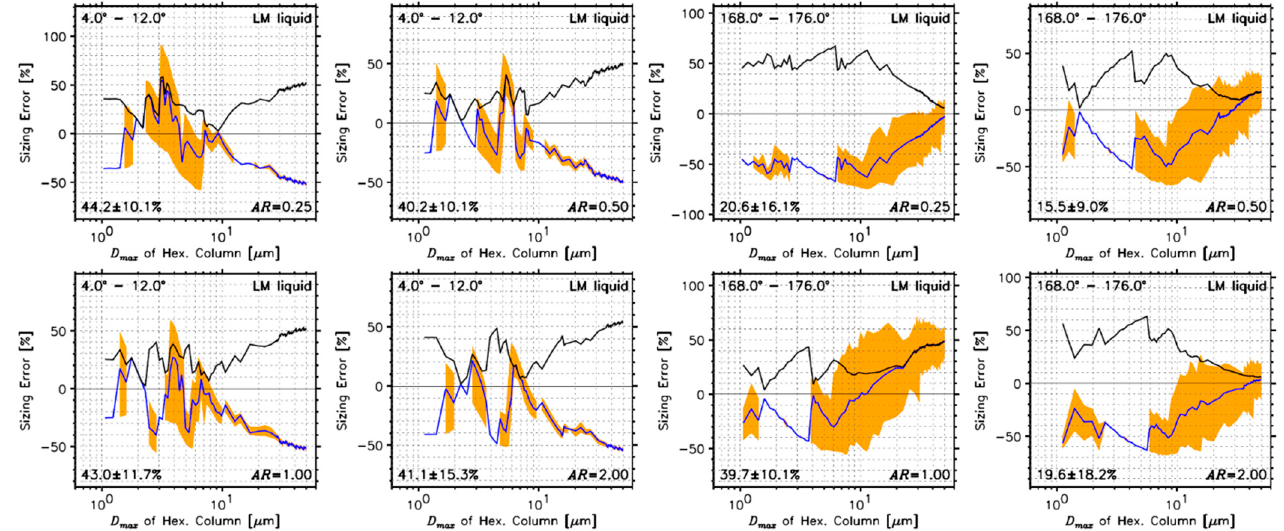
Figure 8. Determined sizing errors of hexagonal ice crystals in forward (4°–12°, left two columns ) and backward (168°–176°, right two columns ) directions. The sizing errors are calculated using an exact comparison between the measured D max of hexagonal ice crystals and those calculated by a Lorenz–Mie code assuming spherical liquid cloud droplets (LM liquid). Each panel represents a different aspect ratio of hexagonal ice crystal. The color scheme is the same as Figure 6.